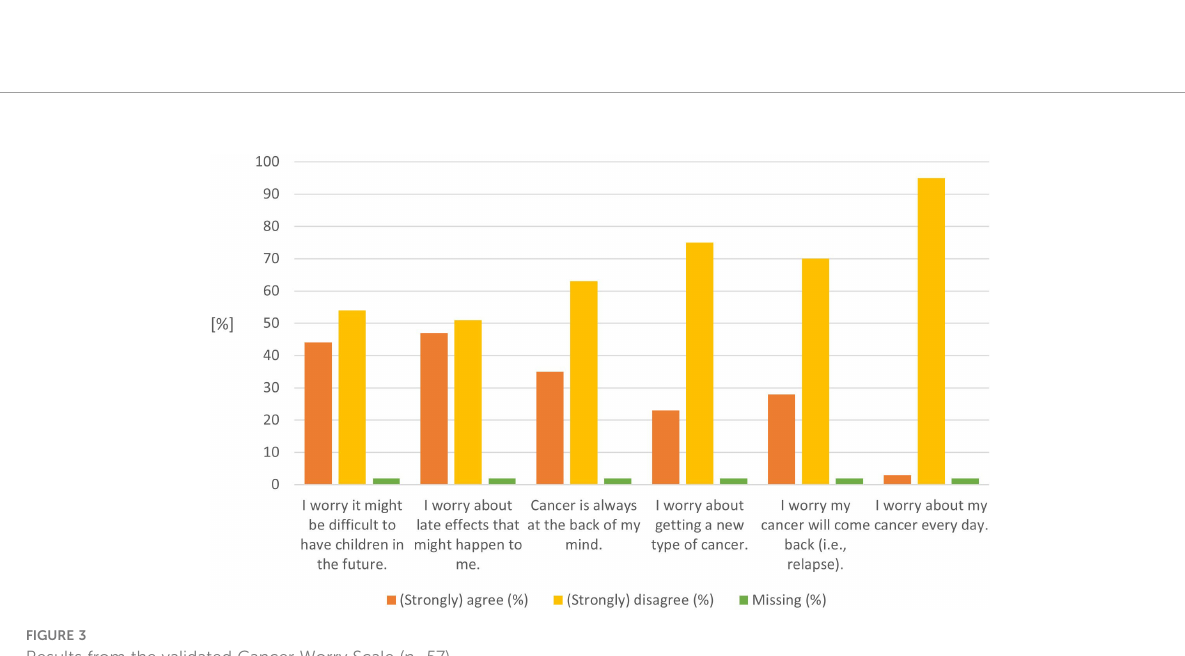
FIGURE 3 Results from the validated Cancer Worry Scale